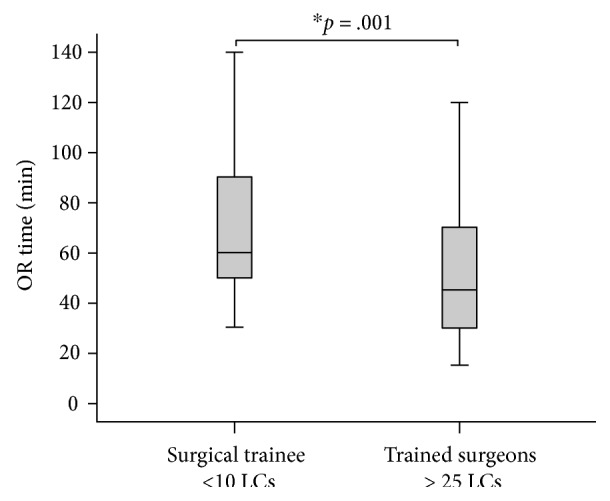
Boxplots (median, interquartile range, max, and min) of LC operative time of surgical trainees and trained surgeons (min). ∗significant differences between surgical trainees and trained surgeons.